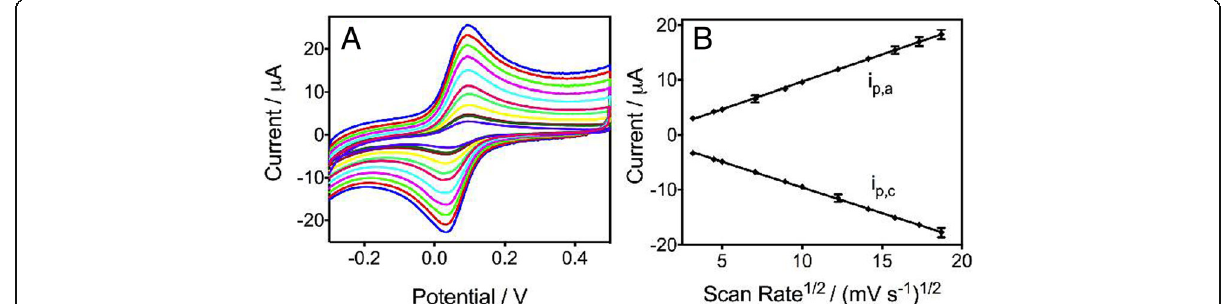
Fig. 3 a Cyclic voltammograms of 0.5 mM ferrocene carboxylic acid in 0.1 M KCl aqueous solution (pH 7.0) in CASPE-MFD at different scan rates (ascending along the y -axis): 10, 25, 50, 80, 100, 150, 200, 250, 300, and 350 mV/s. b Calibration plots of the anodic ( i pa ) and cathodic peak current ( i pc ) vs the square scan rate. The two lines represent a linear curve with regression equation, respectively: Y ( i pa )=0.9932 X − 0.2563 ( R 2 =0.9996, n =8); Y